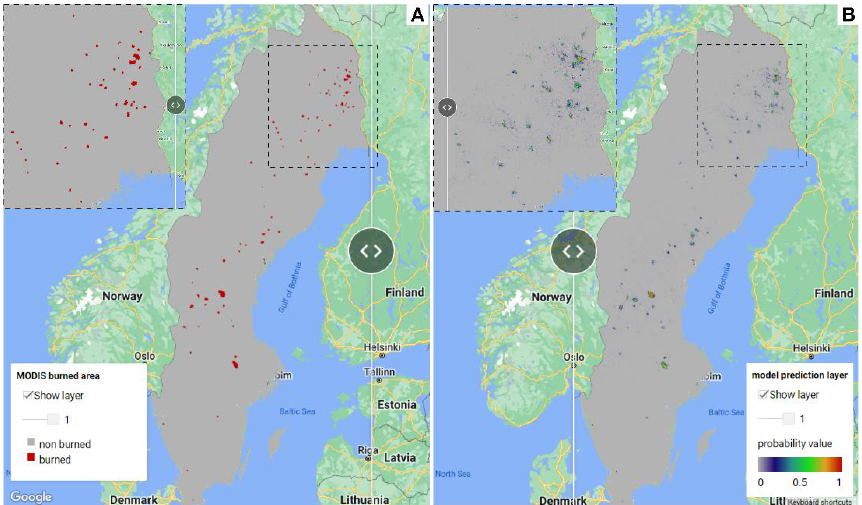
Figure 4. MODIS burned area ( A ) and random forest probability values ( B ) from our Google Earth Engine